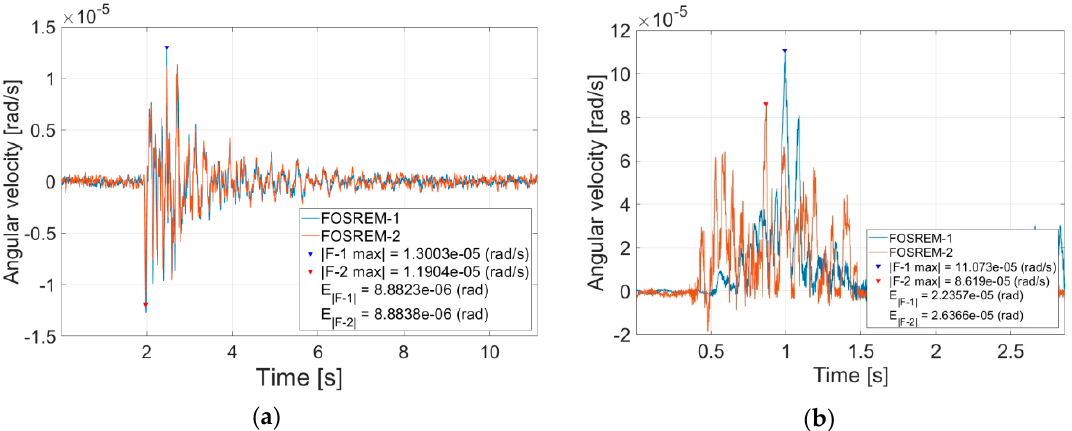
Figure 9. The example of data recorded by the FOSREMs in the geophysical observatory in Ksi ˛a˙z, Poland: ( a ) torsion event on the 1 December 2017, at 12:19 UTC with P C = 0.98, ( b ) tilt event on the 13 December 2017, at 11:15 UTC with P C =